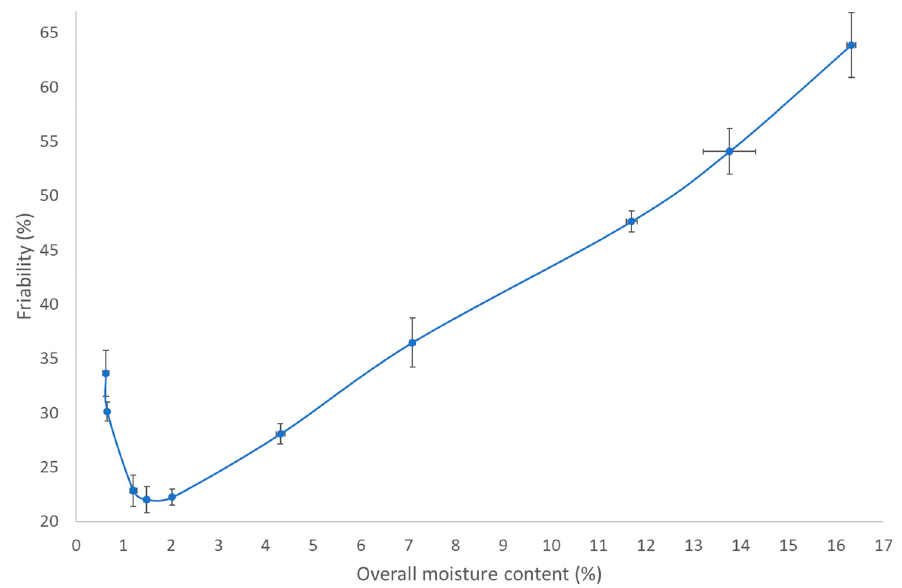
Figure 7. Friability as a function of overall residual moisture content.